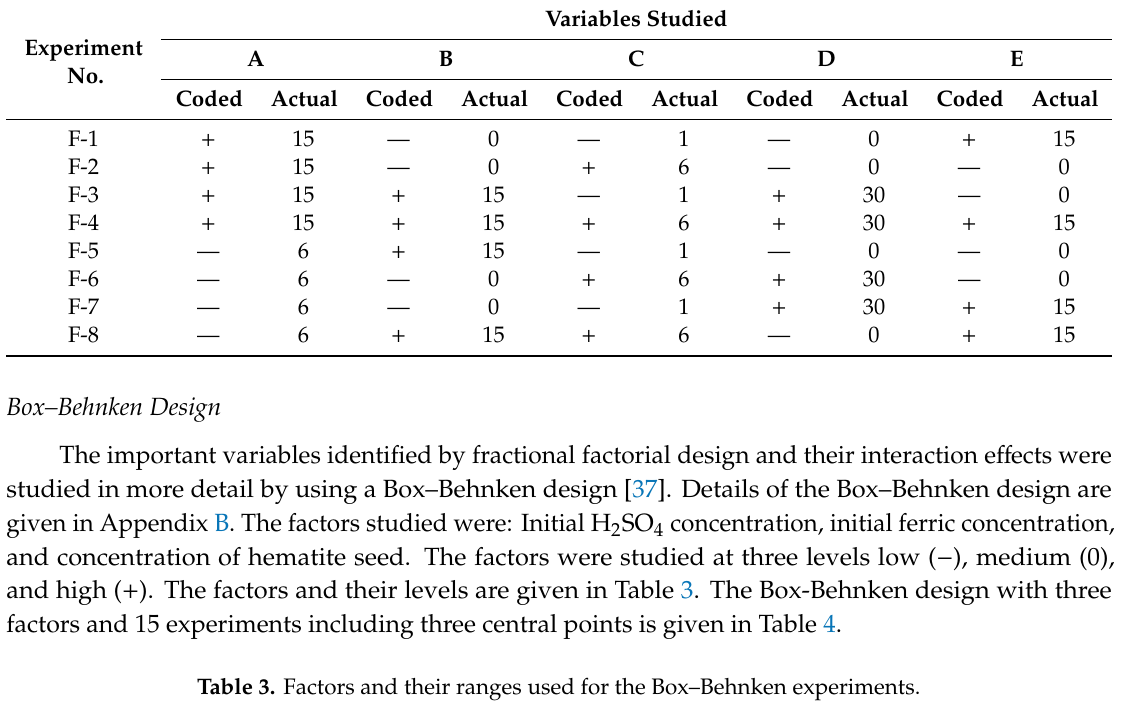
Table 2. Screening experiments for fractional factorial design in coded and actual form.